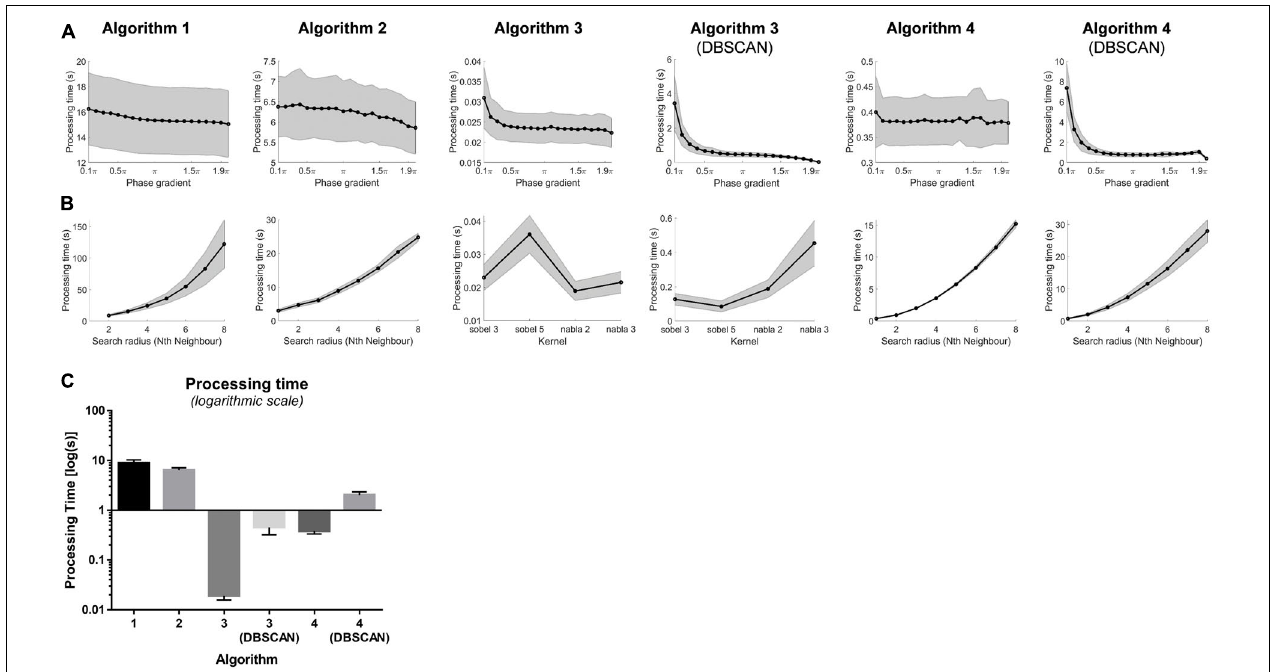
FIGURE 7 | (A) Processing time of the PS detection by changing the phase gradient thresholds. (B) Processing time of the PS detection of different search radius. (C) Processing time (mean and standard deviation) of PS detections using the Algorithms 1–4 and Algorithm 3 and 4 with DBSCAN with optimal thresholds.